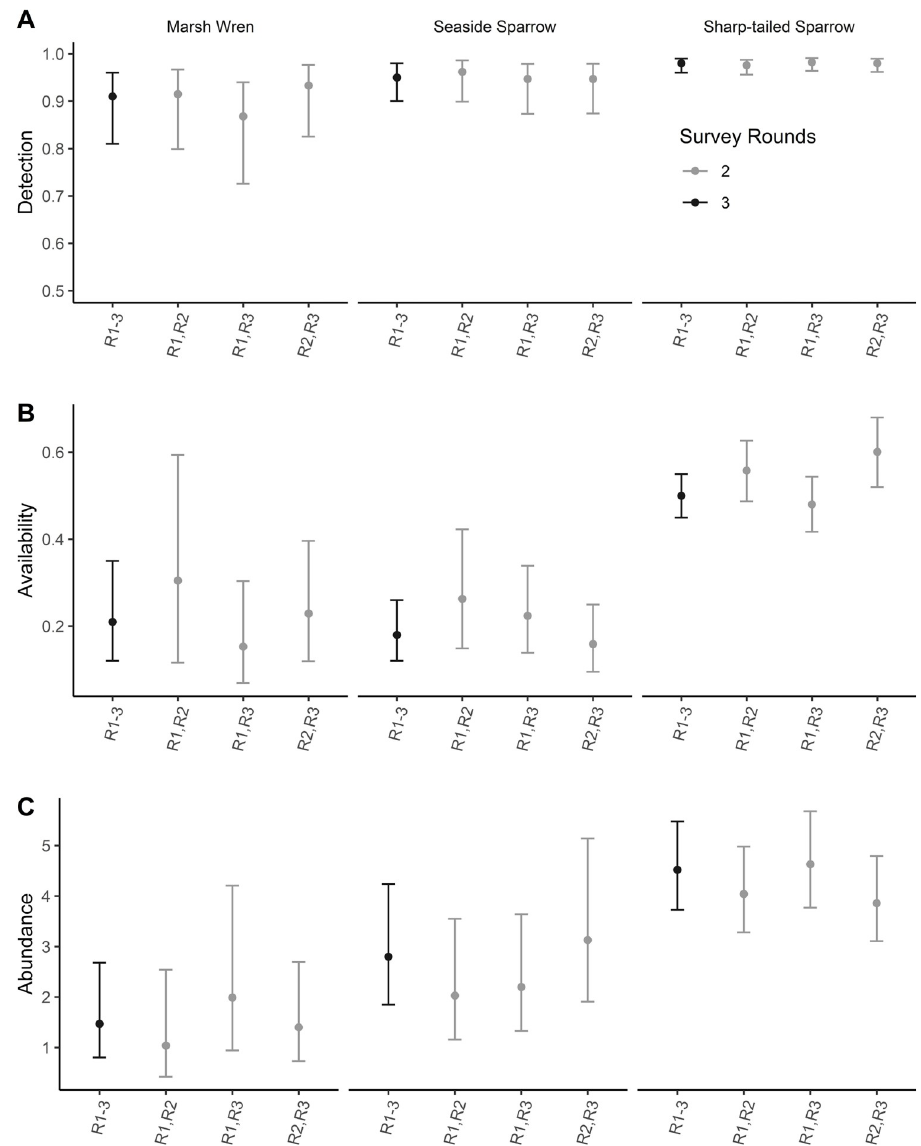
Fig 2. Changes in estimated detection (A), availability (B) and abundance (C) for sharp-tailed sparrows ( Ammospiza nelson and A . caudacutus collectively), seaside sparrows ( A . maritimus ) and marsh wrens ( Cistothorus palustris ) in Virginia, USA during winter 2014 using the double-pass rope-drag technique with different combinations of survey rounds. R1-3 represents results from analyses using the full data sets Rounds 1–3, R1,R2 represents results from analyses using data restricted to that collected during Rounds 1 and 2, R1,R3 represents results from analyses using data restricted to that collected during Rounds 1 and 3, and R2,R3 represents results from analyses using data restricted to that collected during Rounds 2 and 3.